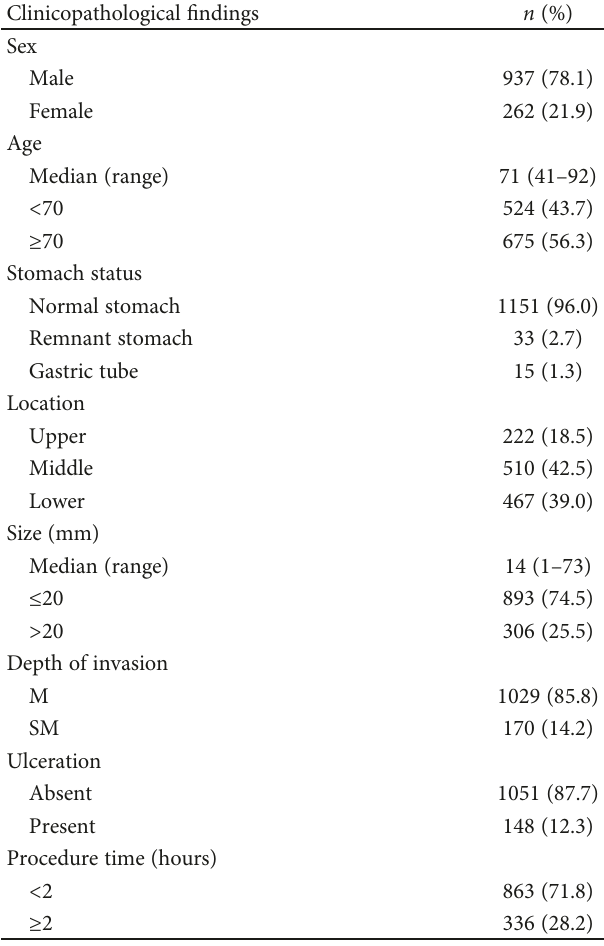
Table 1: Clinicopathological fi ndings of 1199 early gastric neoplasms undergoing endoscopic submucosal